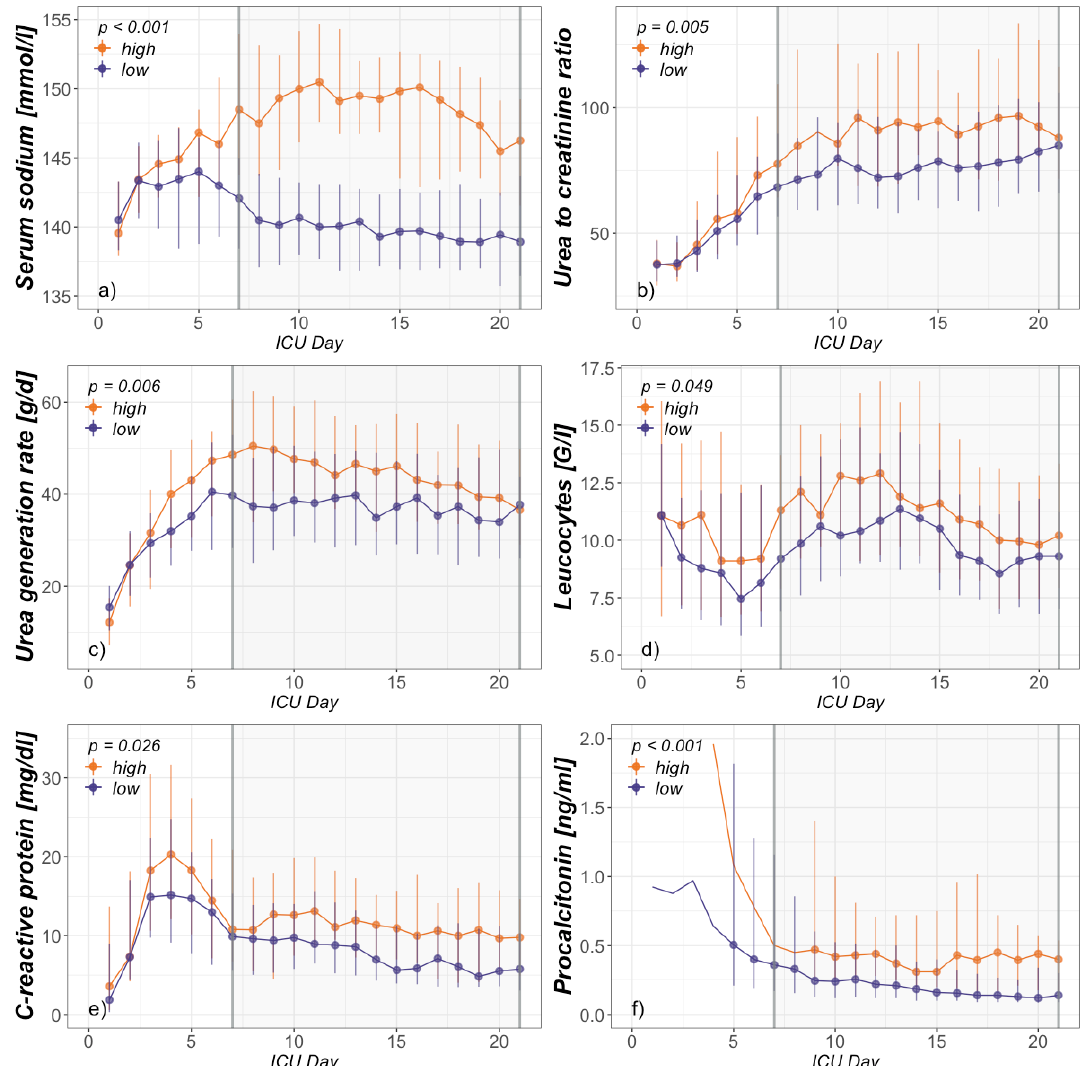
Figure 1. Hypernatremia, catabolism and inflammation. Intensive care unit (ICU) day-dependent group analysis presented as daily median and interquartile range from admission to day 21 of ( a ) serum sodium, ( b ) urea-to-creatinine ratio, ( c ) urea generation rate, ( d ) leucocytes, ( e ) C-reactive protein